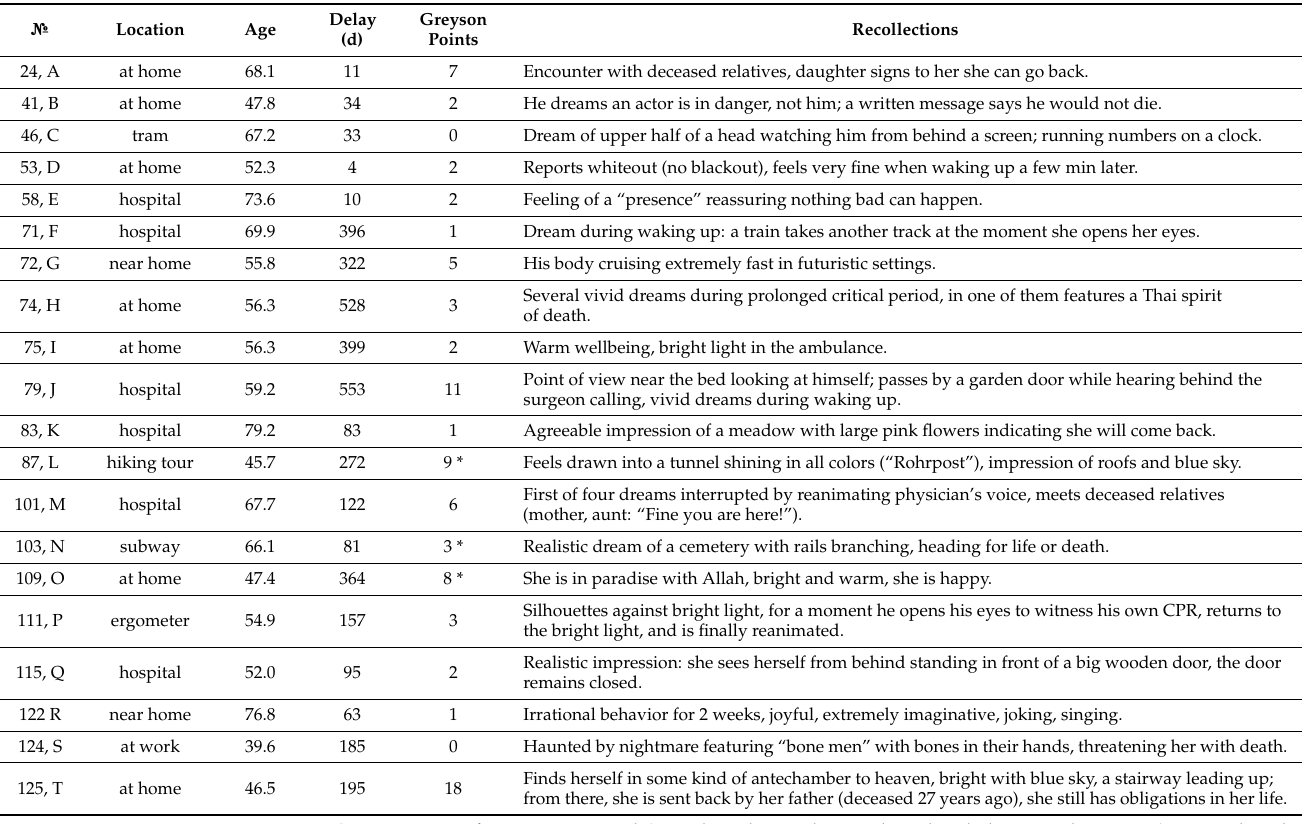
Table 1. Twenty cases with detailed recollections after recovery from CA. Location of CA, age at CA, delay of interview after CA, points scored at the Greyson